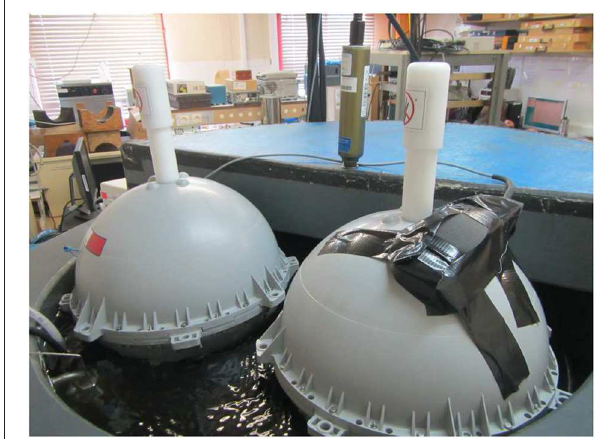
FIGURE 6 | Buoys in the calibration bath, close to the reference thermometer. A pt100 (cid:127) thermometer is fixed on one of them and protected with a piece of foam.